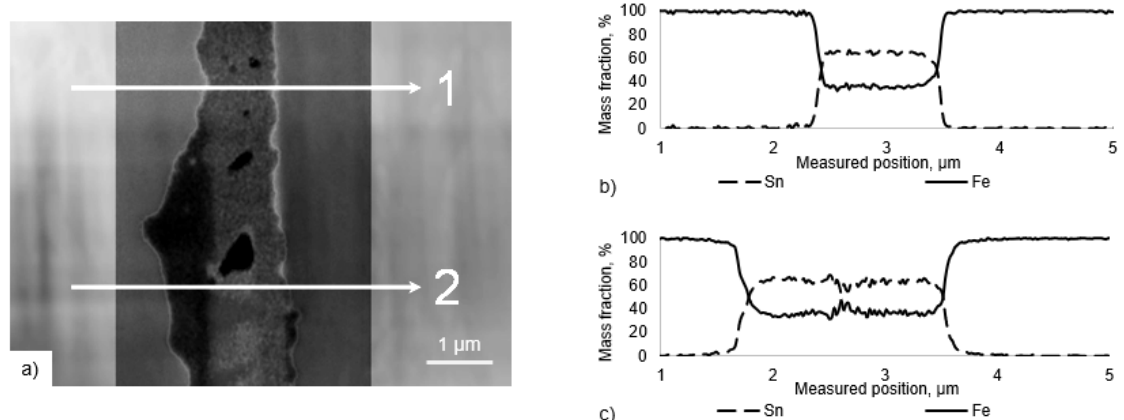
Figure 6. Image of the FIBed section from the sample treated at 250 °C for 30 min ( a ) and corresponding line scans ( b , c ).